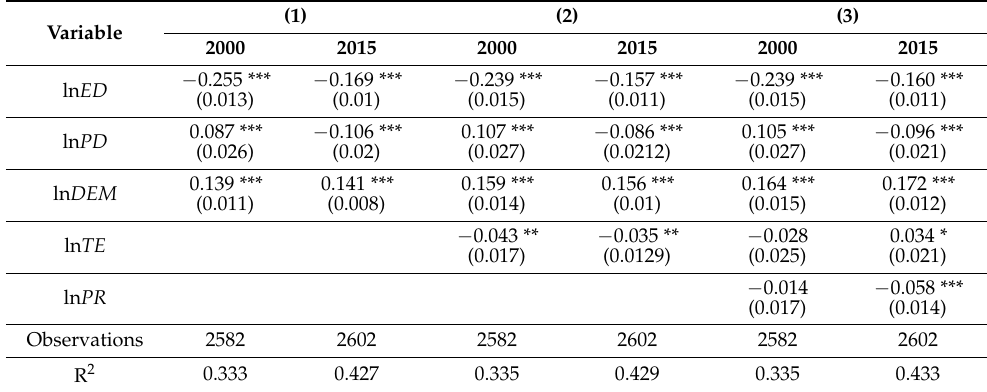
Table 3. Parameter estimation of OLS regression in 2000 and